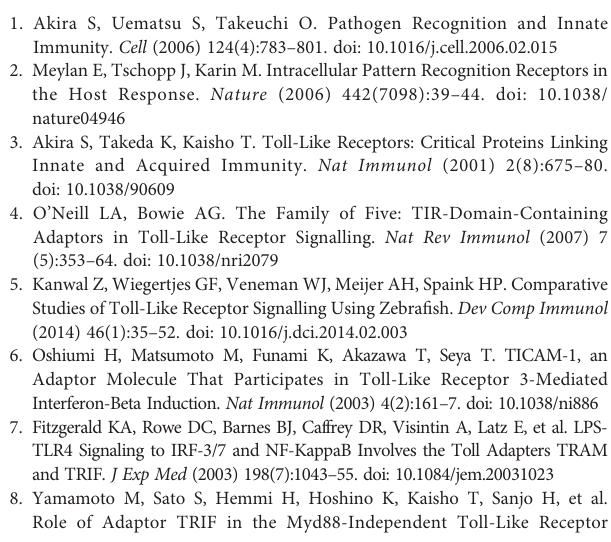
Supplementary Figure 1 | Nucleotide and deduced amino acid sequence of carp TRIF. The cDNA sequence and amino acid sequence of TRIF in Carp. Uppercase letters denote the coding region and lowercase letters show the UTR. The deduced amino acid sequence is shown below the coding regions and the polyadenylation signal attaaaisinbold font.Theredboxrepresents the TIR domain. Supplementary Figure 2 | The multiple alignment of TRIF across species. The sequences were aligned using the Clustal W method. The identical, conservative and similar substituted amino acid residues are indicated in (*), (: or .),